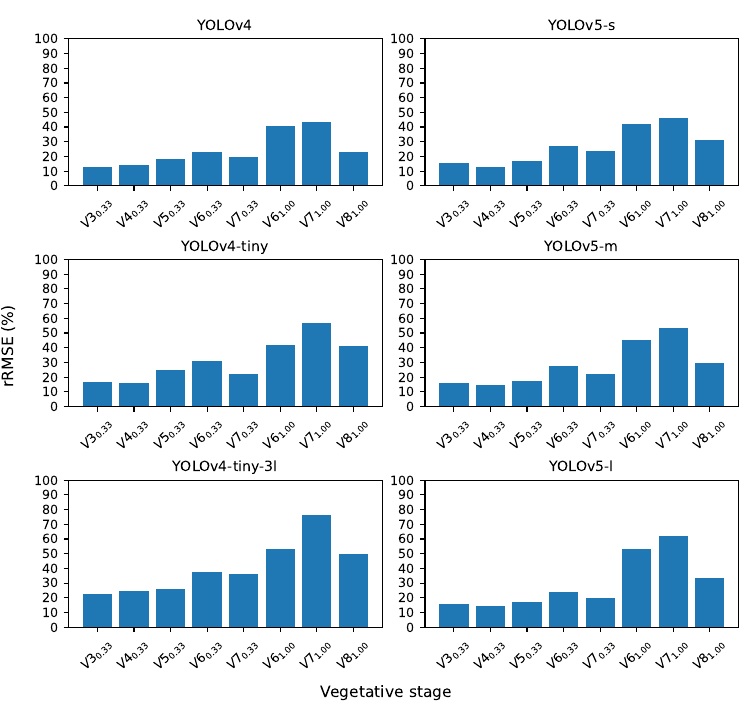
Figure 12. rRMSE obtained for each model by vegetative stage and spatial